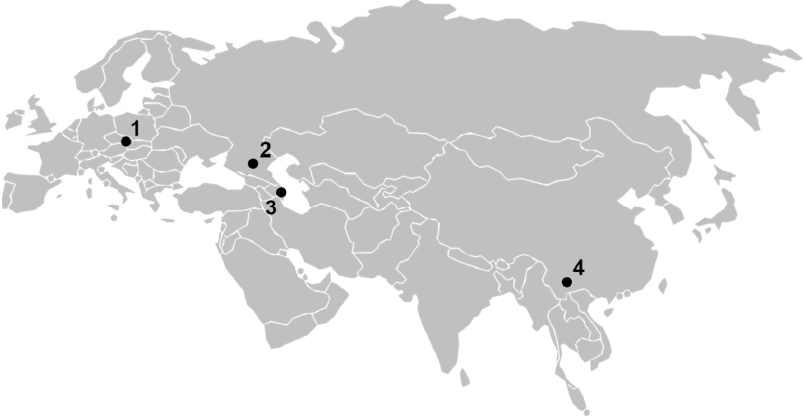
Figure 2. Current geographical distribution of Kyzylagach virus: 1—South Moravia (Czech Republic); 2—Stavropol region (southern Russia); 3—Kyzylagach preserve (Azerbaijan); 4—Yili river, Xinjiang (China).